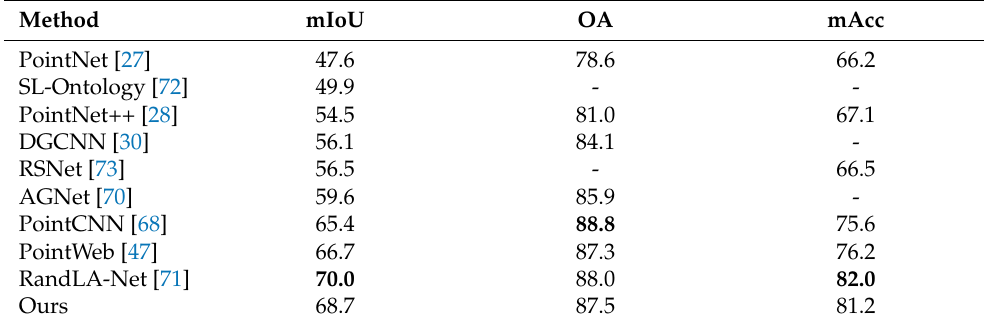
Table 2. Results of 6-fold cross validation on the S3DIS dataset (%). The best scores in the table are marked in bold font.